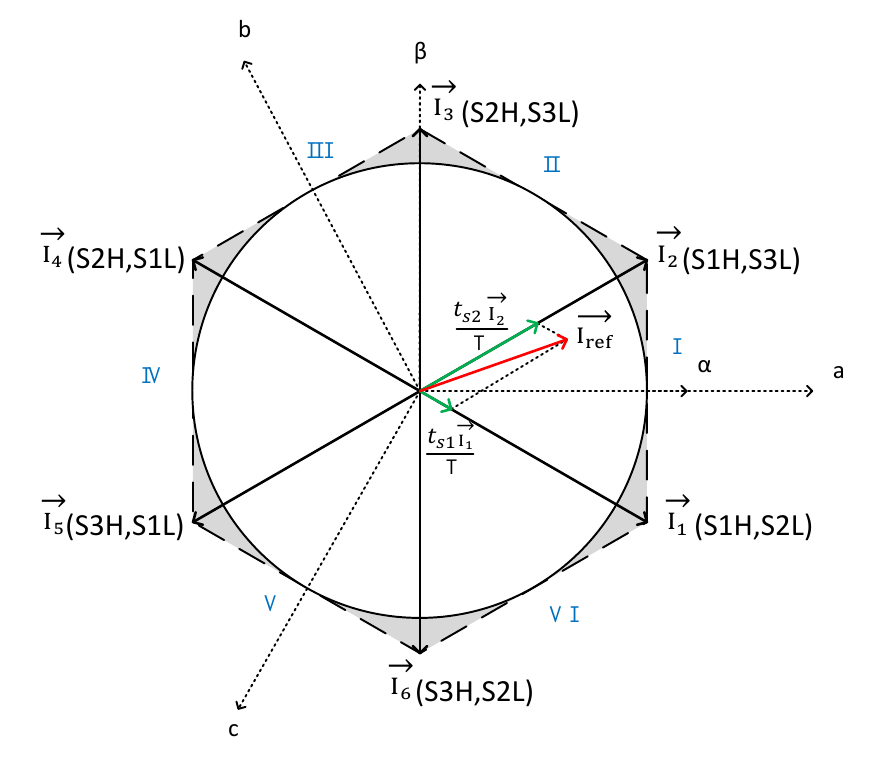
Figure 5. Space Vector